Question: What form of chart is displayed?
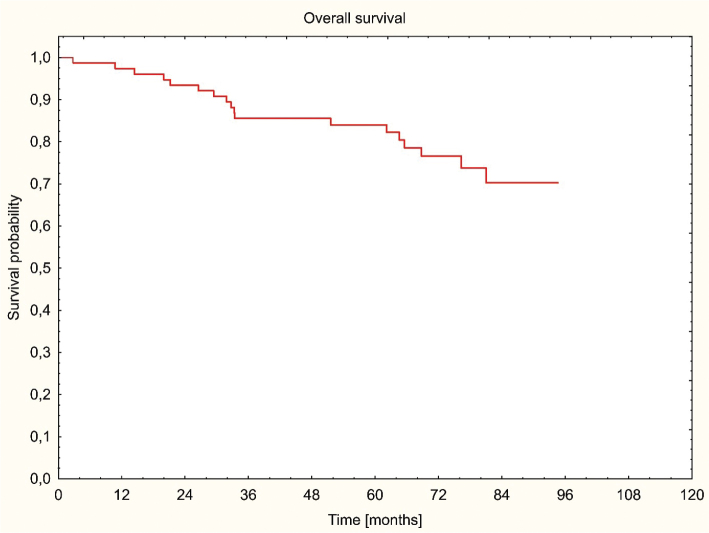
Answer: survival